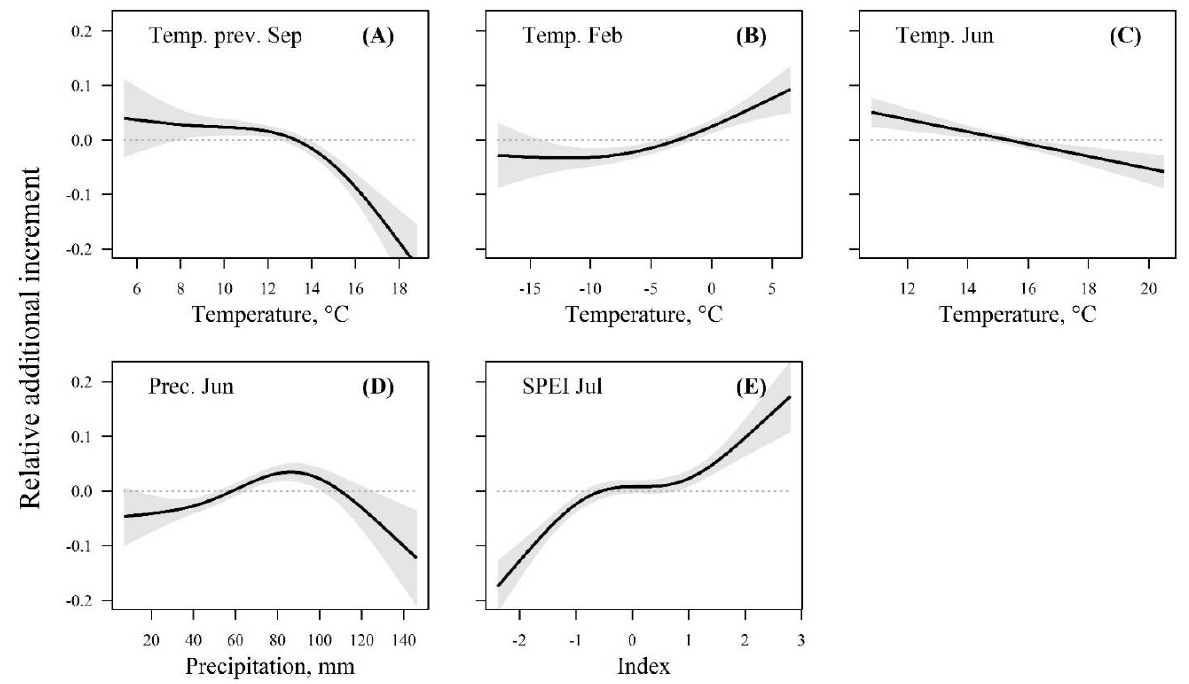
Figure 3. The estimated approximate smoothing splines (dashed lines denote 95% confidence intervals) of the responses of relative additional radial increment (tree-ring width index) of Eastern Baltic Norway spruce to meteorological variables (monthly mean temperature in previous September ( A ), February ( B ), and June ( C ), precipitation sum in June ( D ), and standardized precipitation evapotranspiration index SPEI in July ( E )) across the regional climatic gradient in 1954– 2017. Table 4. Statistics of smoothing splines of the generalized additive mixed model of the relation- ships between the relative additional radial increment (tree-ring index) of Norway spruce from the Eastern Baltic region and meteorological variables: month mean temperature, precipitation, and precipitation evapotranspiration index (SPEI) during the 1954–2017 period.